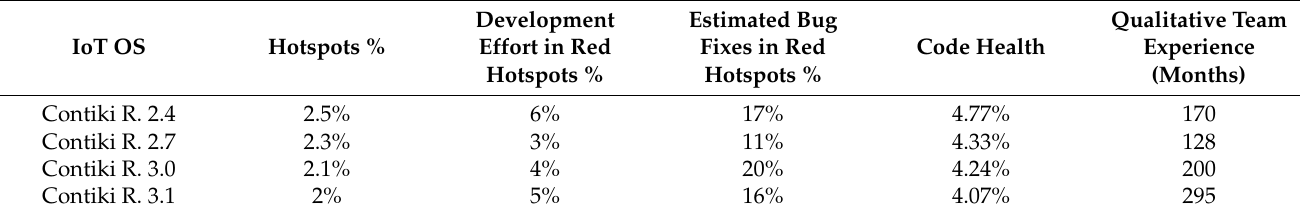
Table 12. CodeScene analysis results for